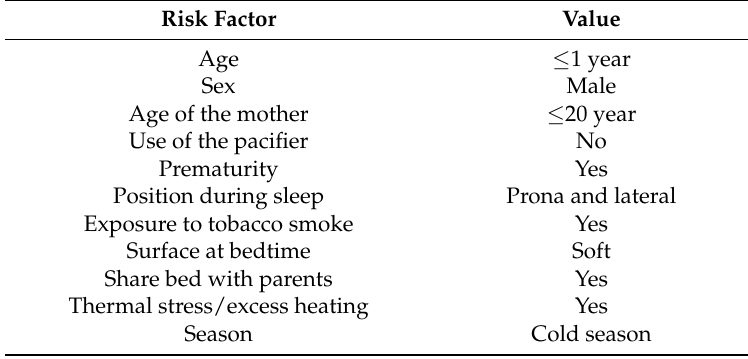
Table 2. Major Risk Factors for the infants described in